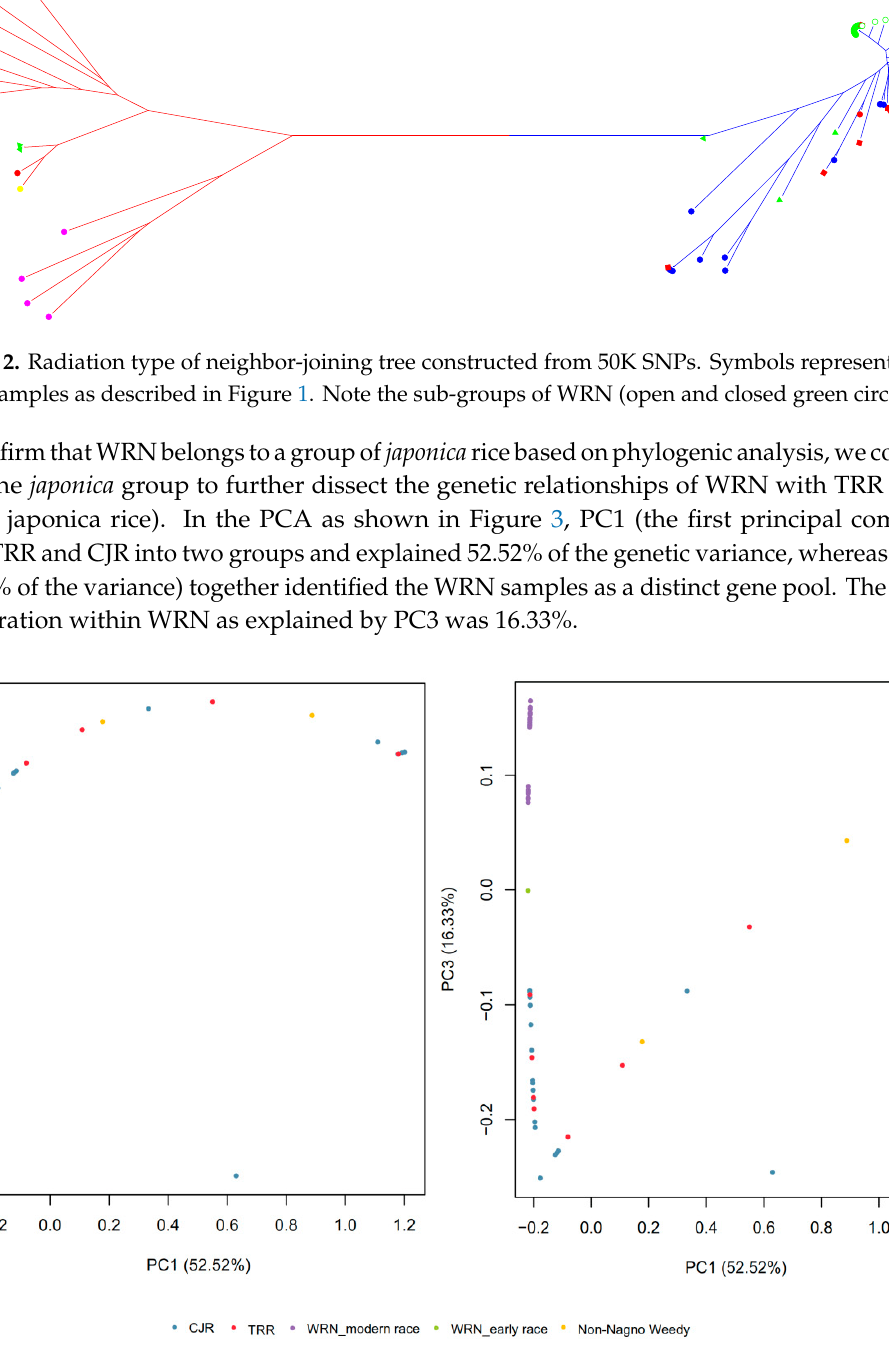
Figure 3. Principal component analysis plots of the first three components of the japonica group. The percentage of genetic variance explained by each principal component are included in the axis labels.